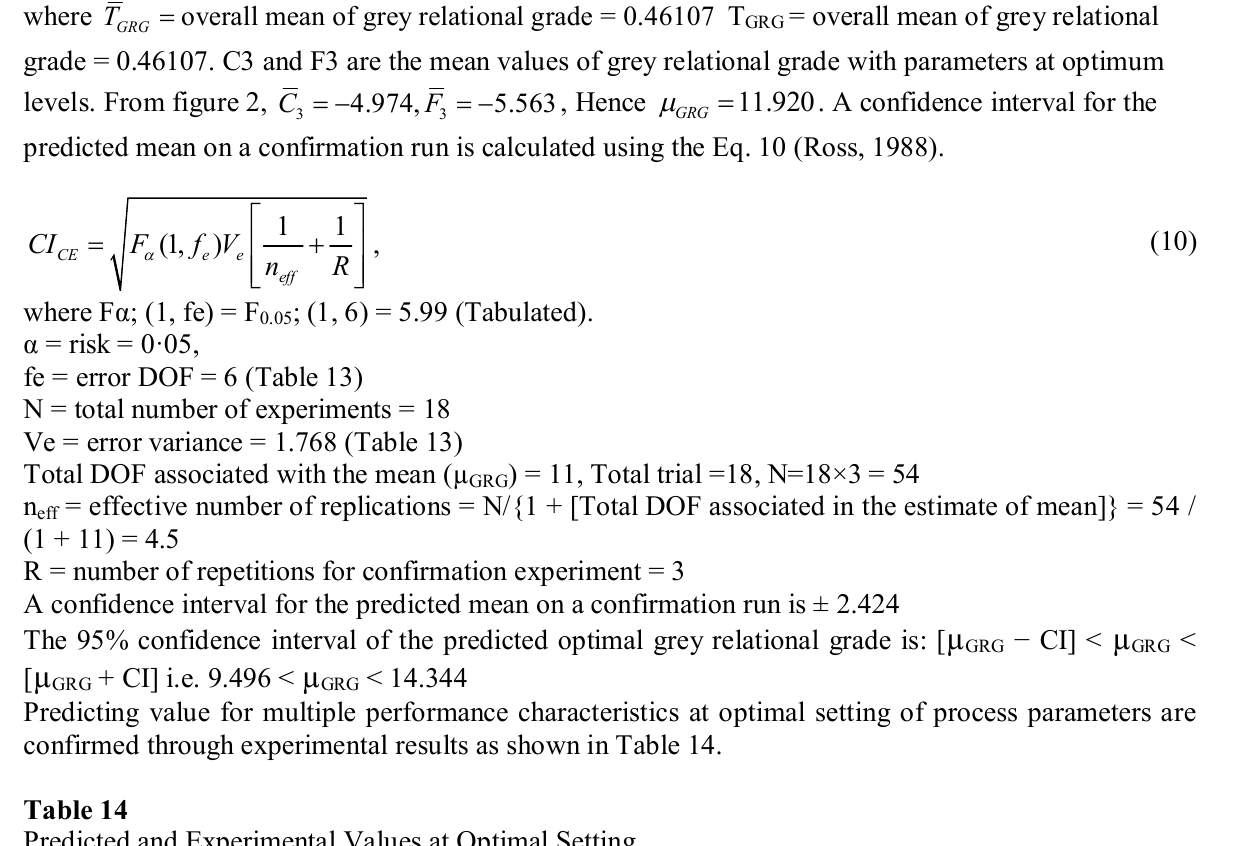
Predicted and Experimental Values at Optimal Setting Performance